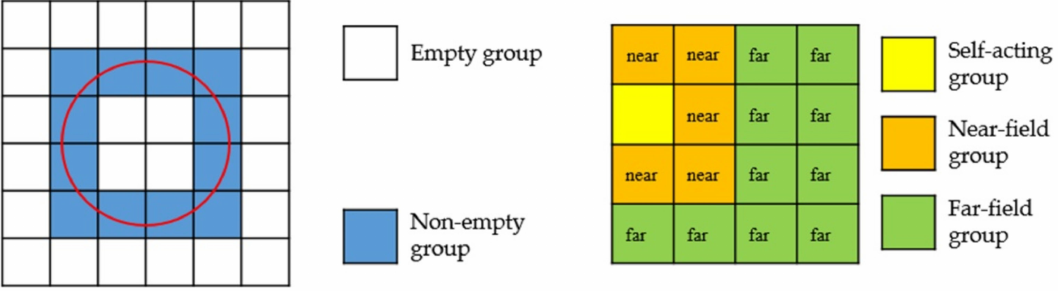
Figure 5. The far and near field diagram of non-empty group